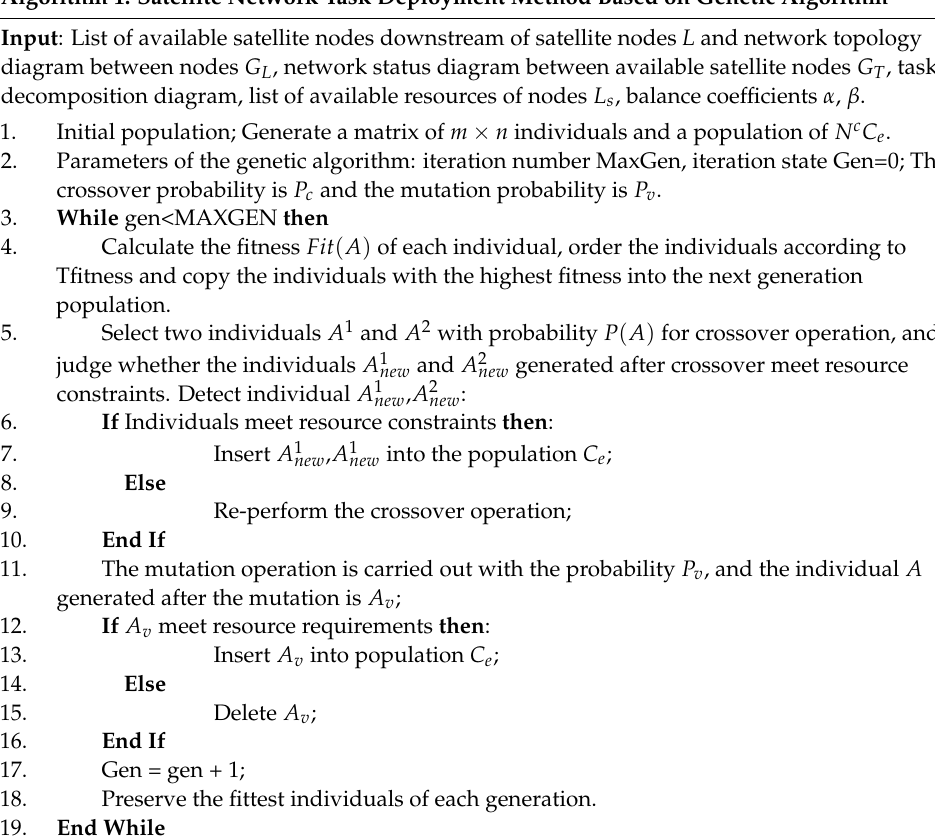
Algorithm 1. Satellite Network Task Deployment Method Based on Genetic